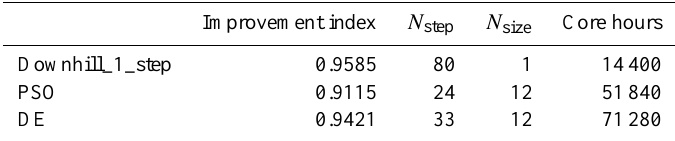
Table 3. Effectiveness and efficiency comparison between the original downhill simplex method and the two global methods. N step is the total number of calibrating iterations for convergence. N size is the number of model runs during each iteration. Core hours is computed by N step N size {the number of processes of a single model run} × × model run takes 6h and uses 30 processes.